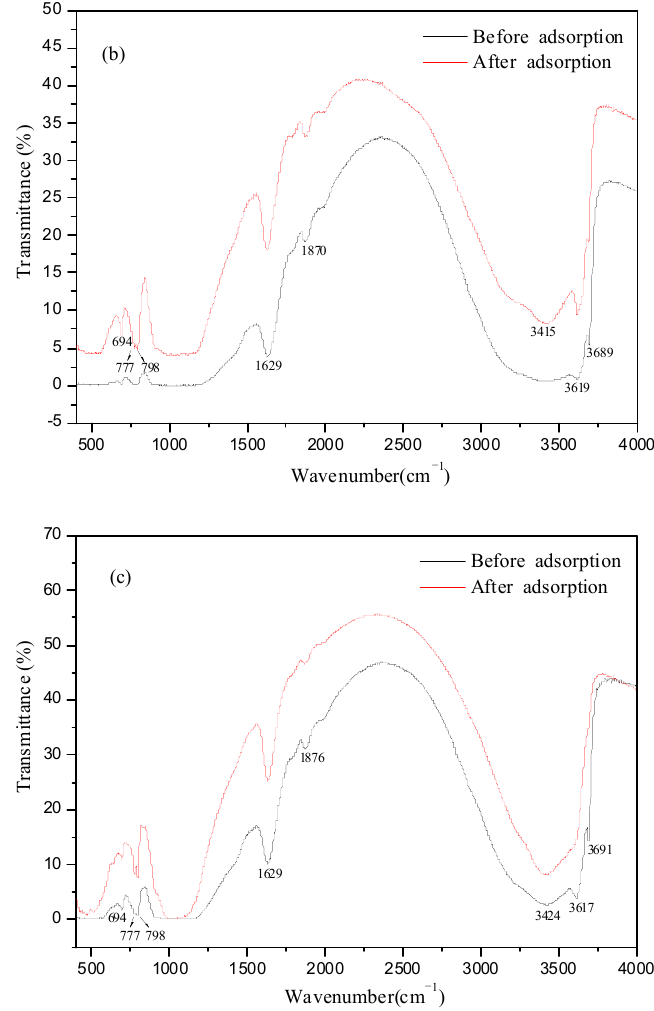
Figure 6. Infrared spectra of each soil before and after Fe 3+ adsorption: ( a ) top layer of loess soils; ( b ) core layer of loess soils and ( c ) subsoil layer of loess soils.